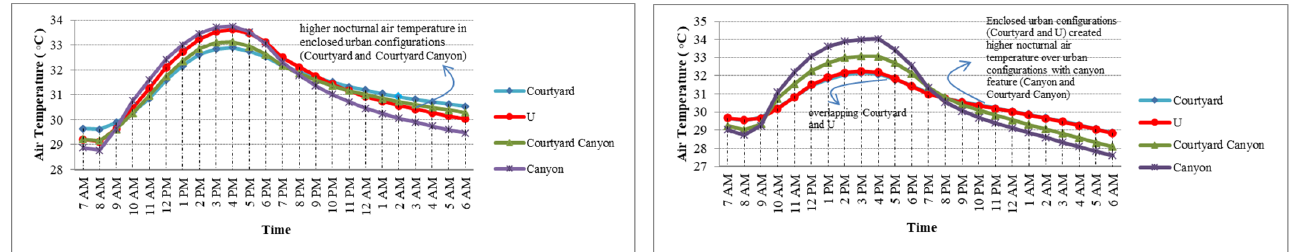
Figure 11. Mean radiant temperature vs. time at FBTS ( left ) and SM ( right ).